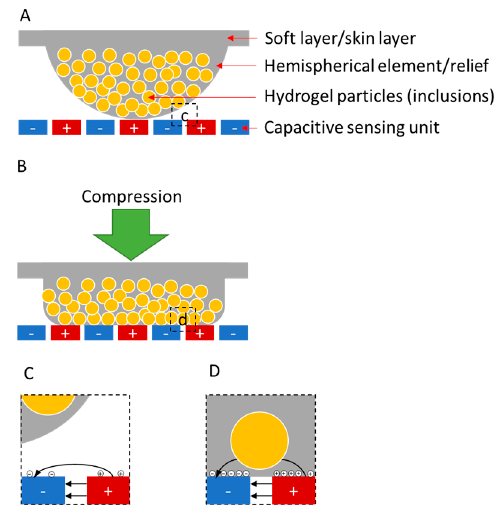
Figure 1. Profile of a force-sensing button. ( A ) Each sensor/button consists of a soft layer (skin-like interface) and a layer of metallized paper with patterned capacitive sensing units. The hemispherical element may or may not contain hydrogel particles (inclusions). ( B ) Compression of a button. When an element/relief compresses against the capacitive sensing units in the metallized paper, the element deforms to increase the area of interfacial contact. ( C , D ) Interaction between a capacitive sensing unit and a portion of a hemispherical element. As a hemispherical element/relief makes contact with a capacitive sensing unit, the stored electrical field/charge increases, which results in an increase in measured effective capacitance.